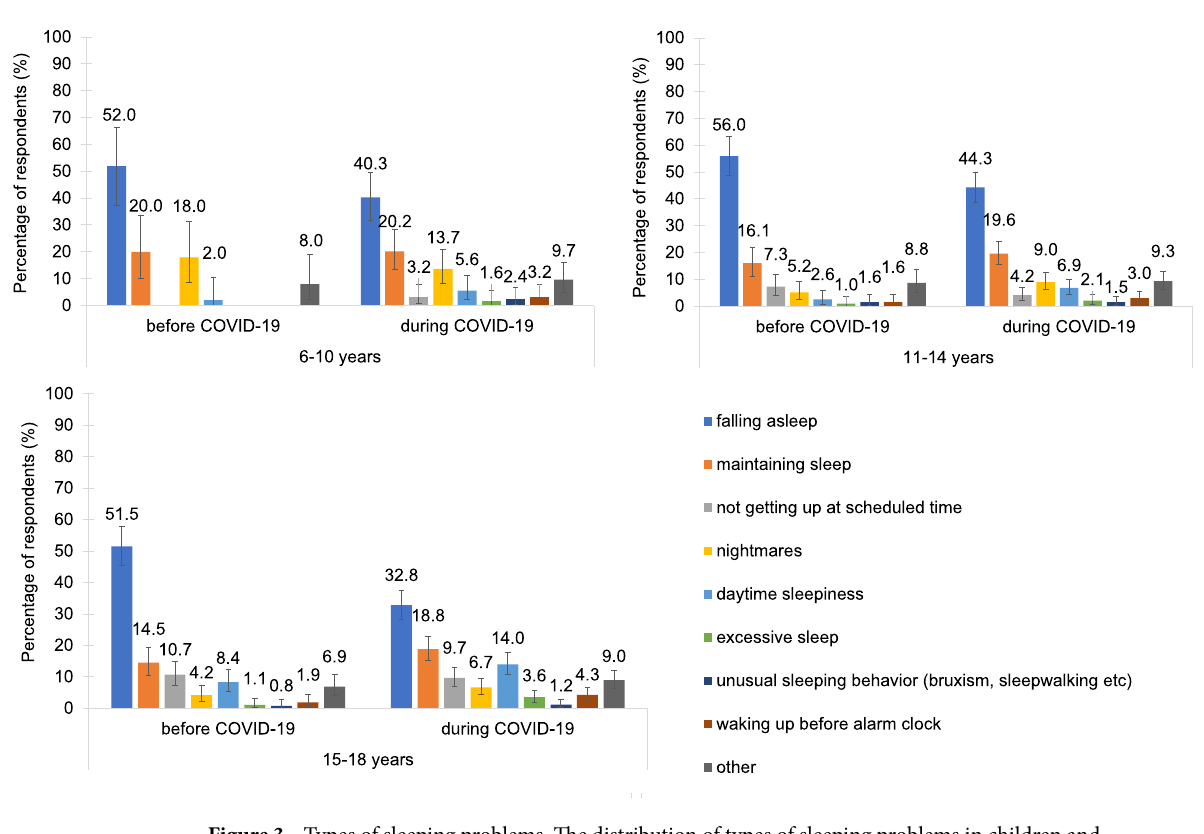
Figure 3. Types of sleeping problems. The distribution of types of sleeping problems in children and adolescents was similar before and during the